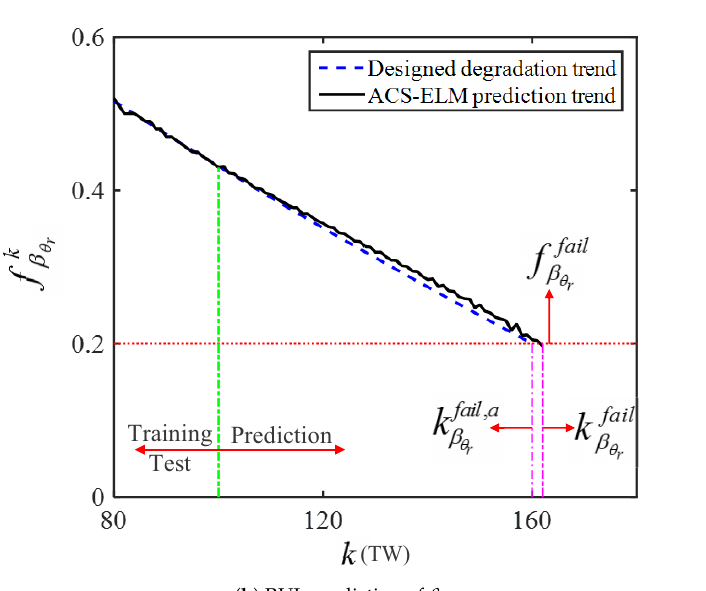
Figure 10. Estimation and prediction results of β θ